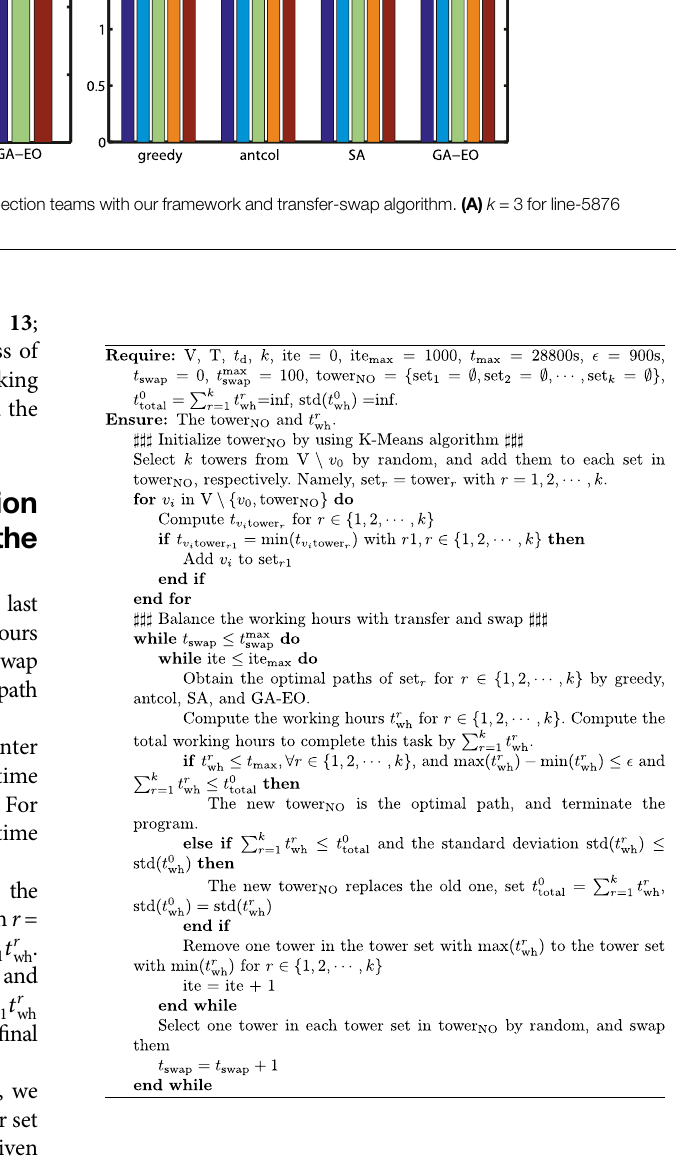
Algorithm 1. Optimal inspection path planning with the transfer-swap algorithm.